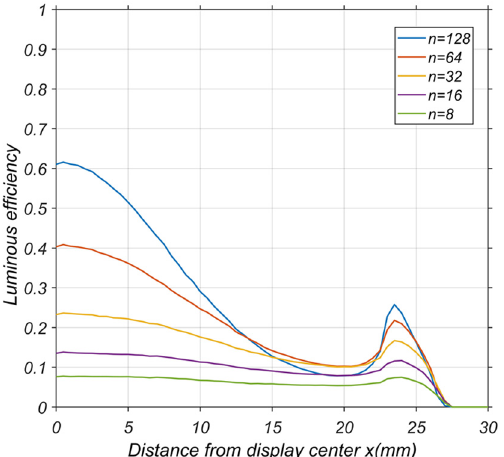
Figure 3. Simulated luminous efficiency of a single pixel in the VR optical module depicted in Fig- ure 2a with the angular luminance distributions shown in Equation (1) and Figure